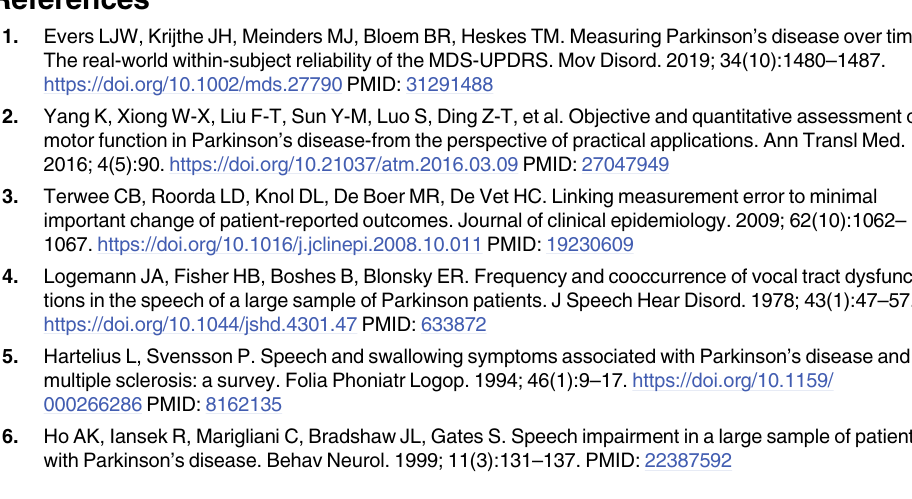
S1 Table. Laryngeal measures during vocalization per participant. Table of summary statis- tics for each laryngeal measure by patient. Mean GA , IAD and IAI and their standard devia- tions (SD) during the vocalization period are listed. The effective minimum GA and IAD and effective maximum IAI listed refers to the median of the five lowest or highest values, whilst the inter-quartile range (IQR) given corresponds to the IQR for these five values. S2 Table. Linear mixed models. Table listing the details of the linear mixed models used to analyse the effect of duration or severity (as graded by UPDRS part-III scores) of PD on the IAD and transformed values of the GA and IAI